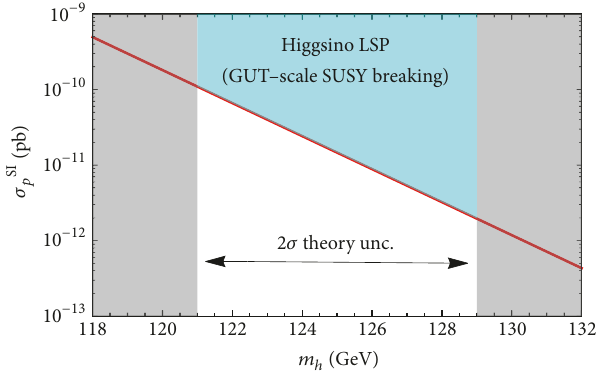
Figure 5: Lower bound on 𝜎 SI 푝 as a function of Higgs mass for a higgsinoLSPofarbitrarymassingenericmodelswherethebreaking of supersymmetry is transmitted at the GUT scale and the physical spectrum and EWSB are obtained after RGE to the low